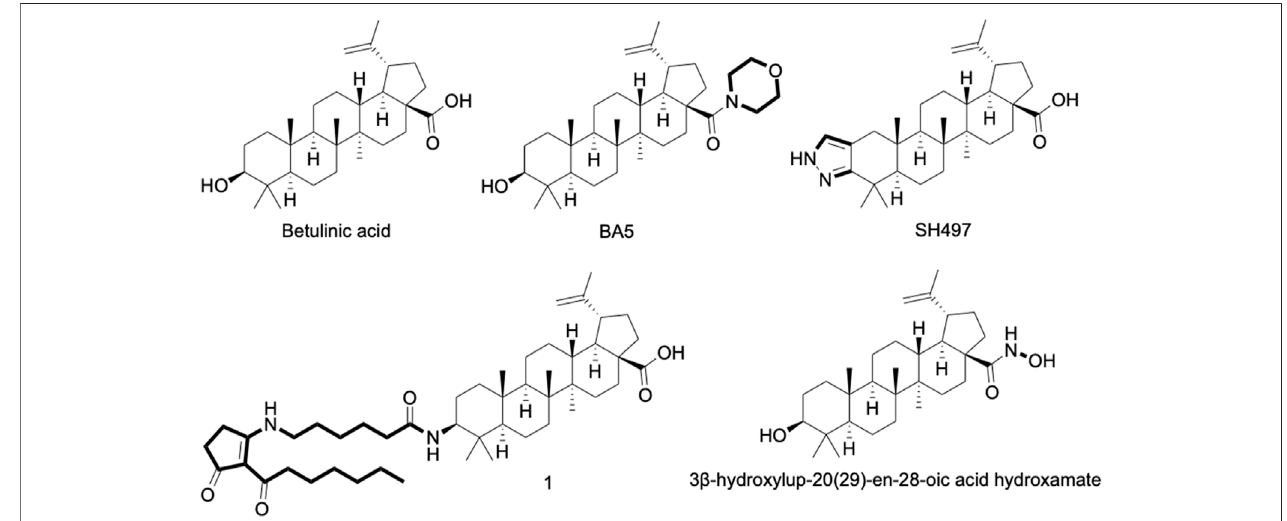
FIGURE 1 | Chemical structure of betulinic acid (BA) and its derivatives with anti-in fl ammatory activity well-known. 1 = 3-Deoxy-3 β -((6-(2-heptanoyl-3- oxocyclopent-1-en-1-yl)amino)hexanamido))betulinic